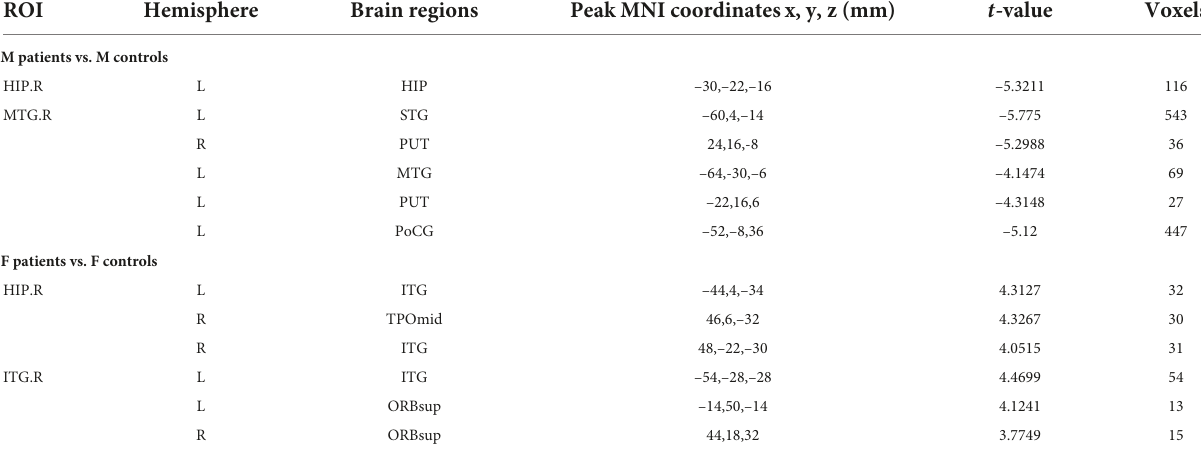
TABLE 5 Significant brain regions identified for ASL analyses of CBF